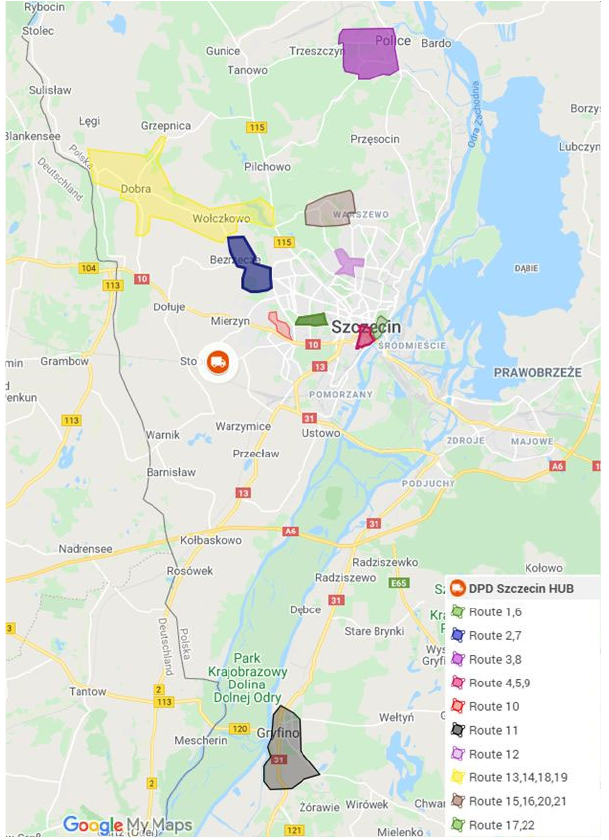
Figure 3. Areas covered by particular routes. Source: Own